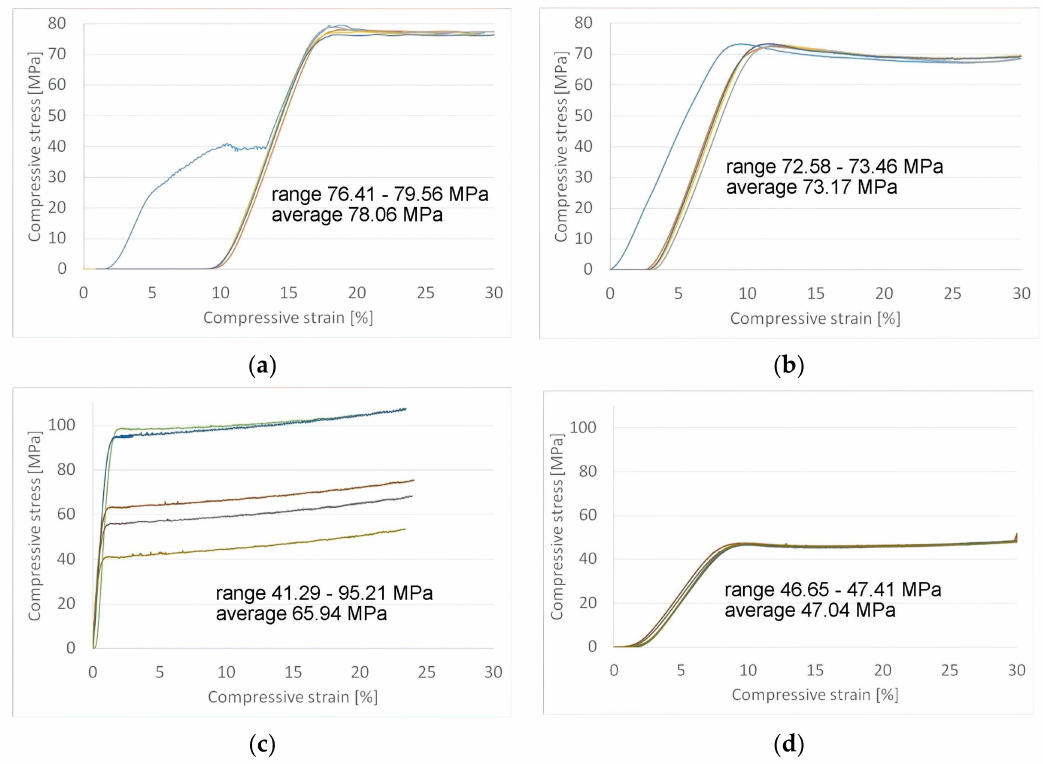
Figure 6. Compressive strength testing results: ( a ) PLA control group; ( b ) PLA with UV–B exposure; ( c ) PETG control group; ( d ) PETG with UV–B exposure.